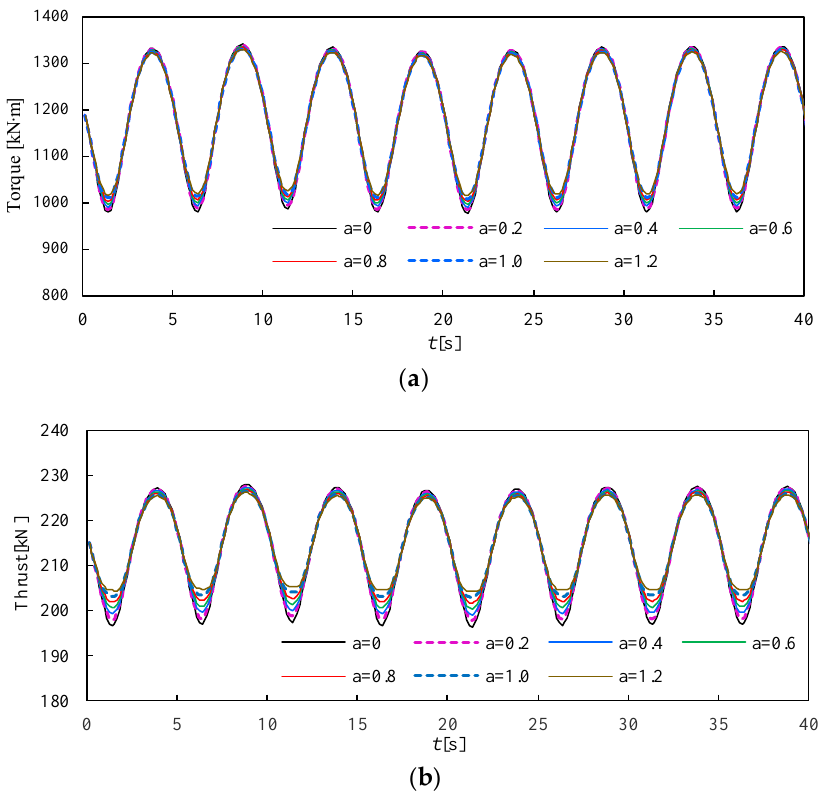
Figure 14. Torque and thrust response of the wind turbine rotor under wind shear conditions for U hub = 11.4 m/s. ( a ) Torque response; ( b ) thrust response.